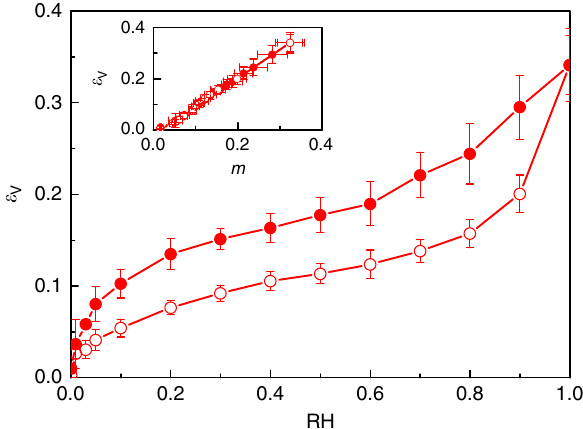
Fig. 3 Sorption-induced swelling of cellulose. Volume strain ε V as a function of relative humidity RH upon water adsorption in cellulose at T = 300 K ( ε V is de fi ned as V / V 0 − 1 where V and V 0 are the volumes of the hydrated and dry samples, respectively). The open and closed symbols, which correspond to adsorption and desorption, display a large hysteresis. The insert shows that the volume strain ε V , plotted as a function of moisture content m , is not hysteretic. The error bar is de fi ned as the standard deviation (s.d.) of the three